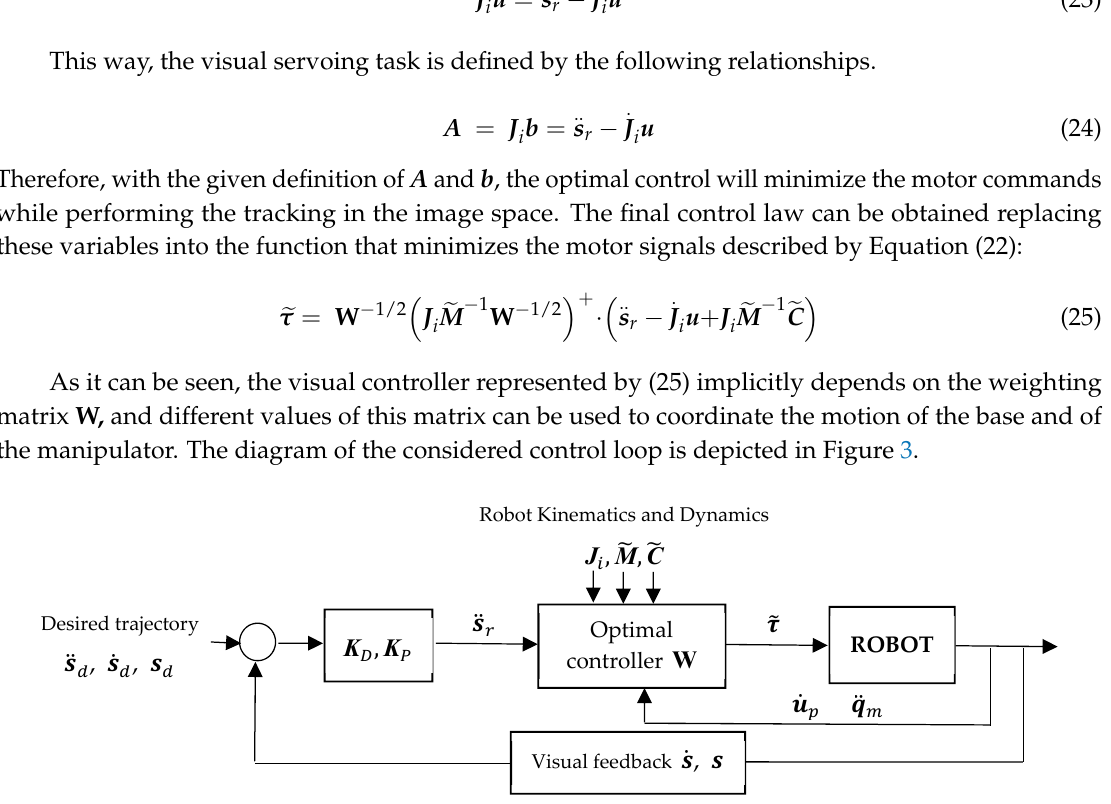
Figure 3. Diagram of the control scheme for the mobile manipulator robot.